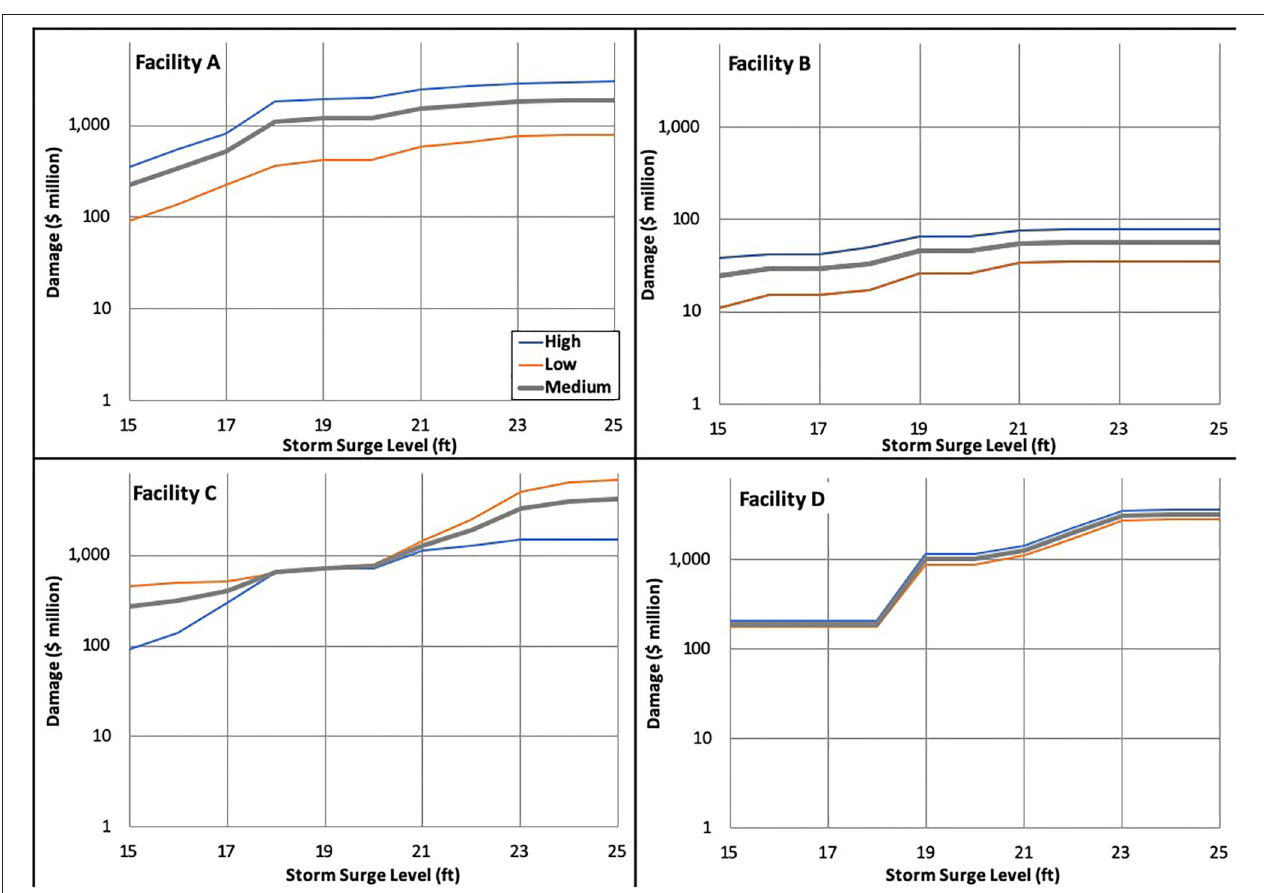
FIGURE 10 | FEDERAP projected losses for 3 scenarios of cost models (blue line: higher estimate, gray line: medium estimate, red line: lower